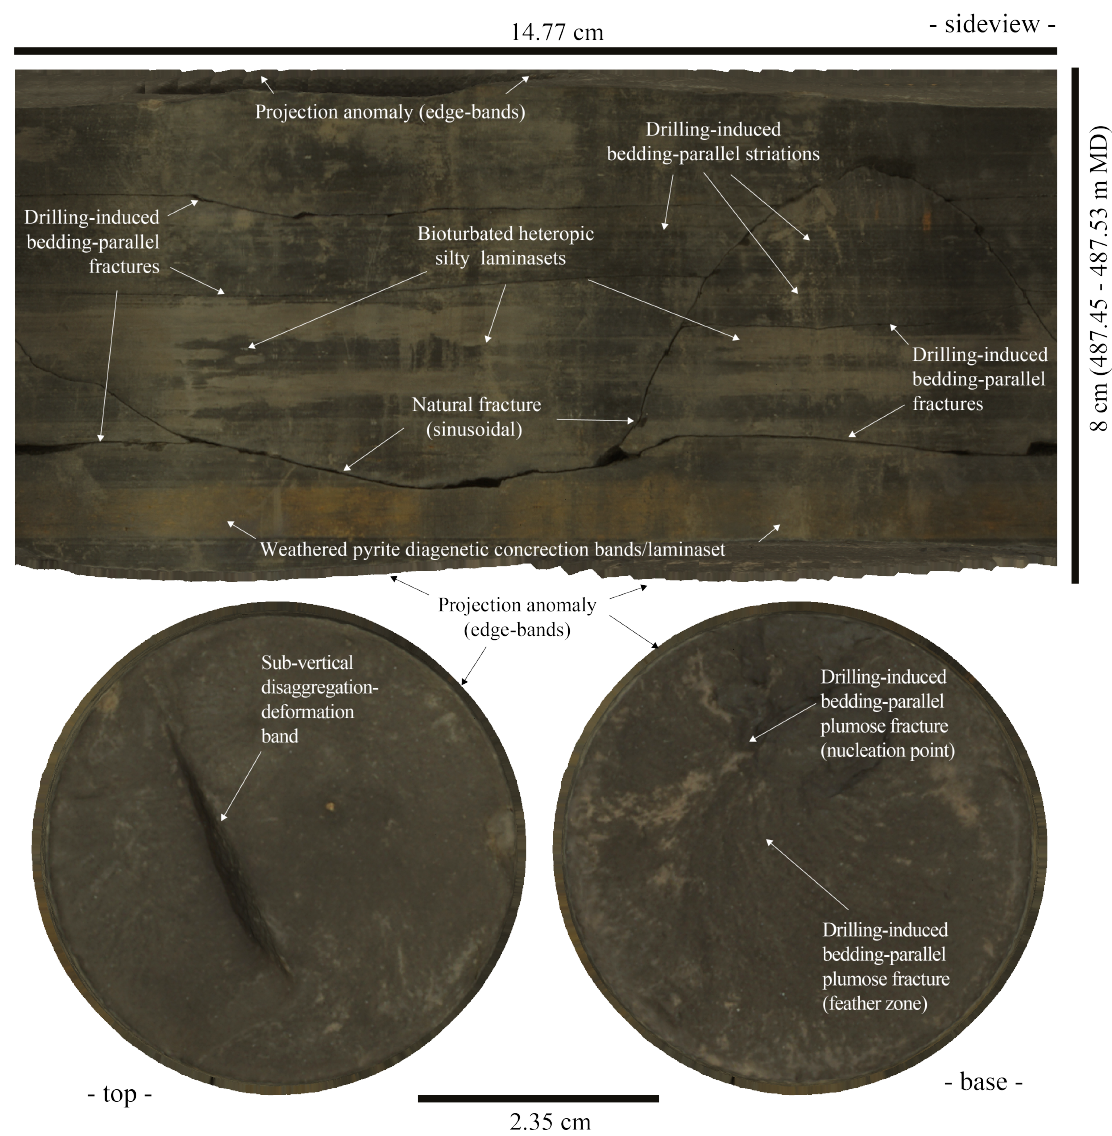
Figure 7. Top, side and base of composite DCM DH4-487.5 with labelling of the main observed structure-sedimentological